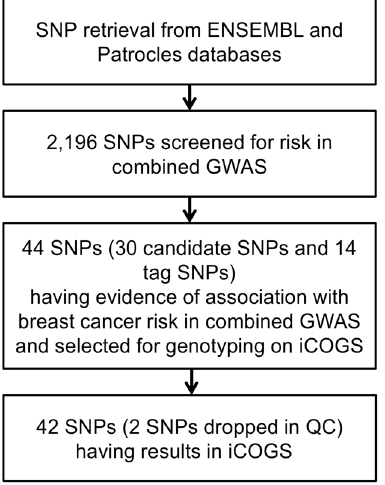
Figure 1. Workflow of miRNA SNP selection.